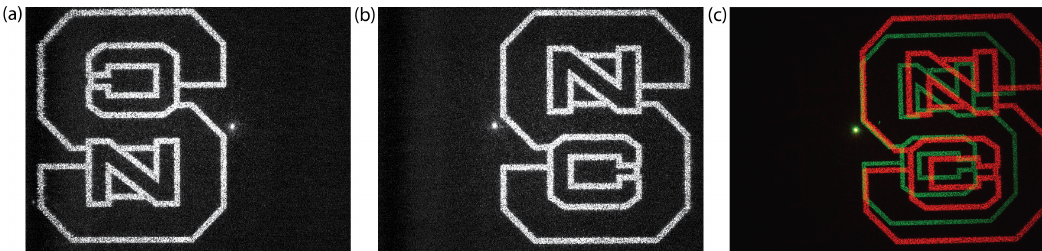
Figure 4. Measured replay images for a ( a ) 633-nm laser with opposite circular polarization, ( b ) 633-nm laser with desired circular polarization and ( c ) 633-nm and 532-nm lasers with desired circular polarization.